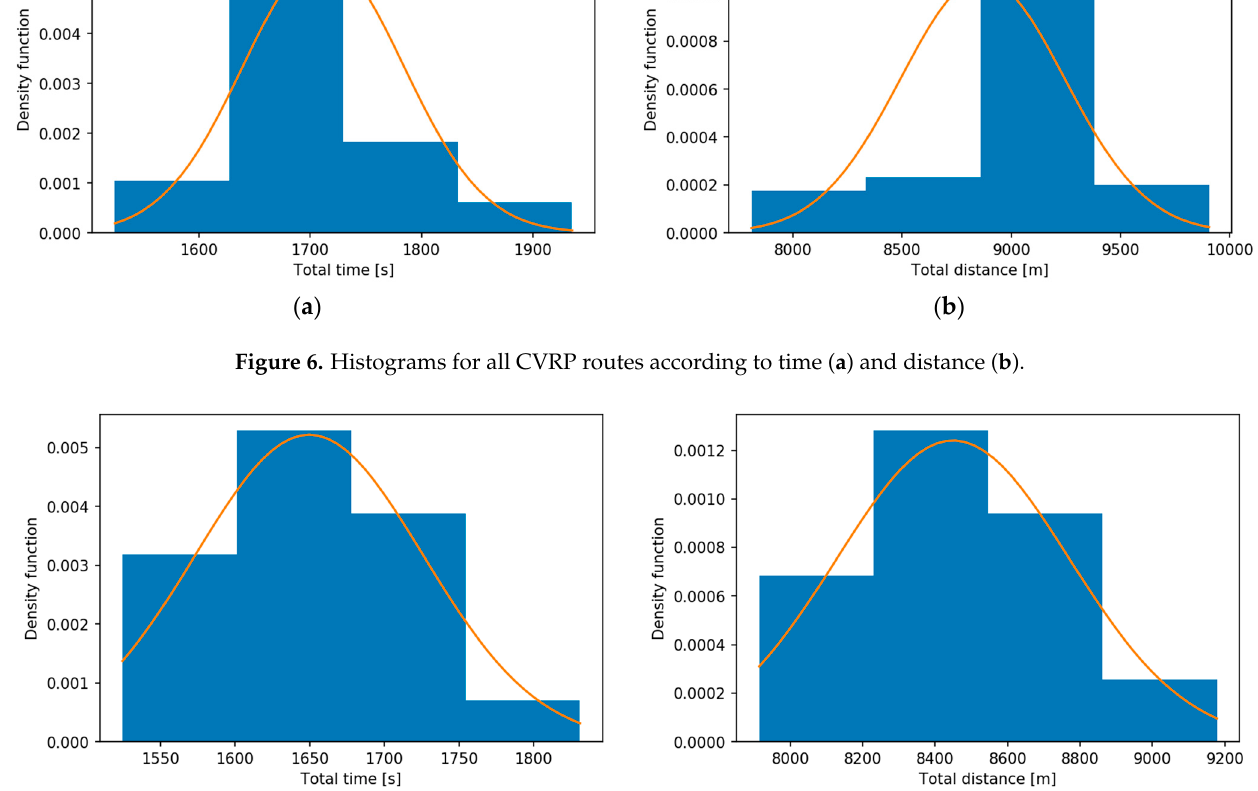
Figure 7. Histograms for all 3D feasible CVRP routes according to time ( a ) and distance ( b ).